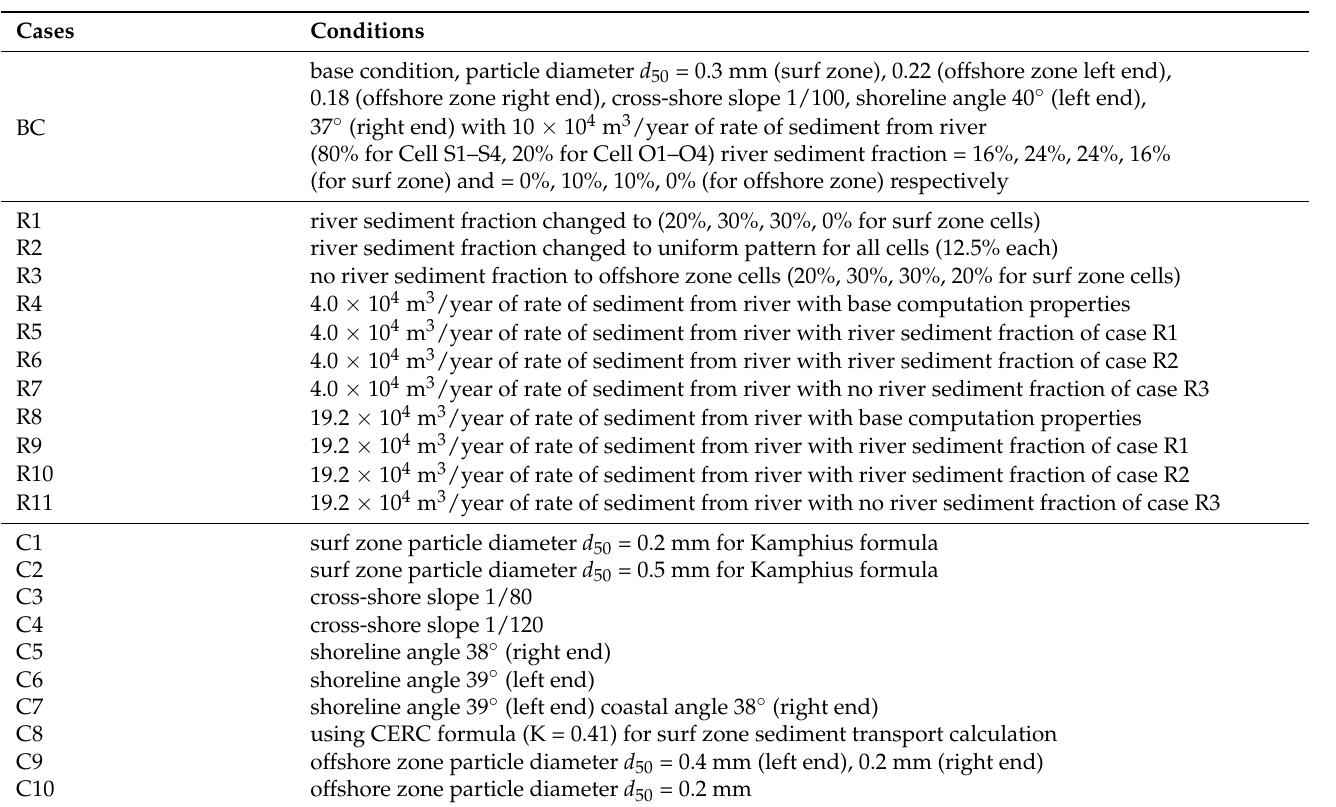
Figure 8. Cumulative and net sediment transport in the offshore zone, both cumulative and net value in each interval (calculated approximately once a year based on the date of bathymetric surveys conducted annually). Since sediment moves in both directions, the positive and negative terms are displayed in addition to the value’s sum. Table 3. River and coastal boundary conditions for the sensitivity analysis of the sediment budget of the Ishikawa